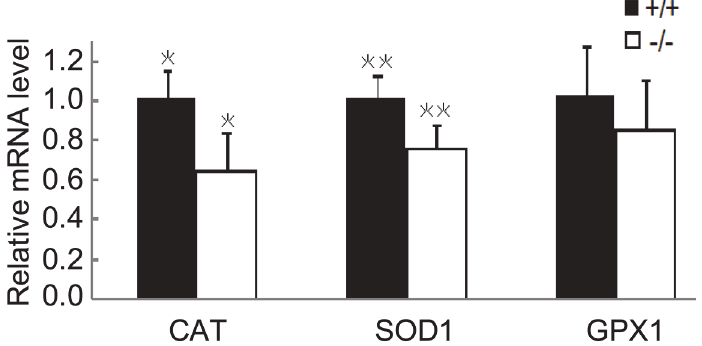
Fig 5. The gene expression levels of antioxidant enzymes are reduced in Lgr4 − / − mice older than 24 weeks. The lens epithelium from Lgr4 − / − mice and their wild-type littermates was isolated as described in Materials and Methods. Total RNA was extracted and the gene expression was measured by real-time PCR. The data were normalized to the level in wild-type mice. Results are expressed as mean ± SEM. n = 3, * P <